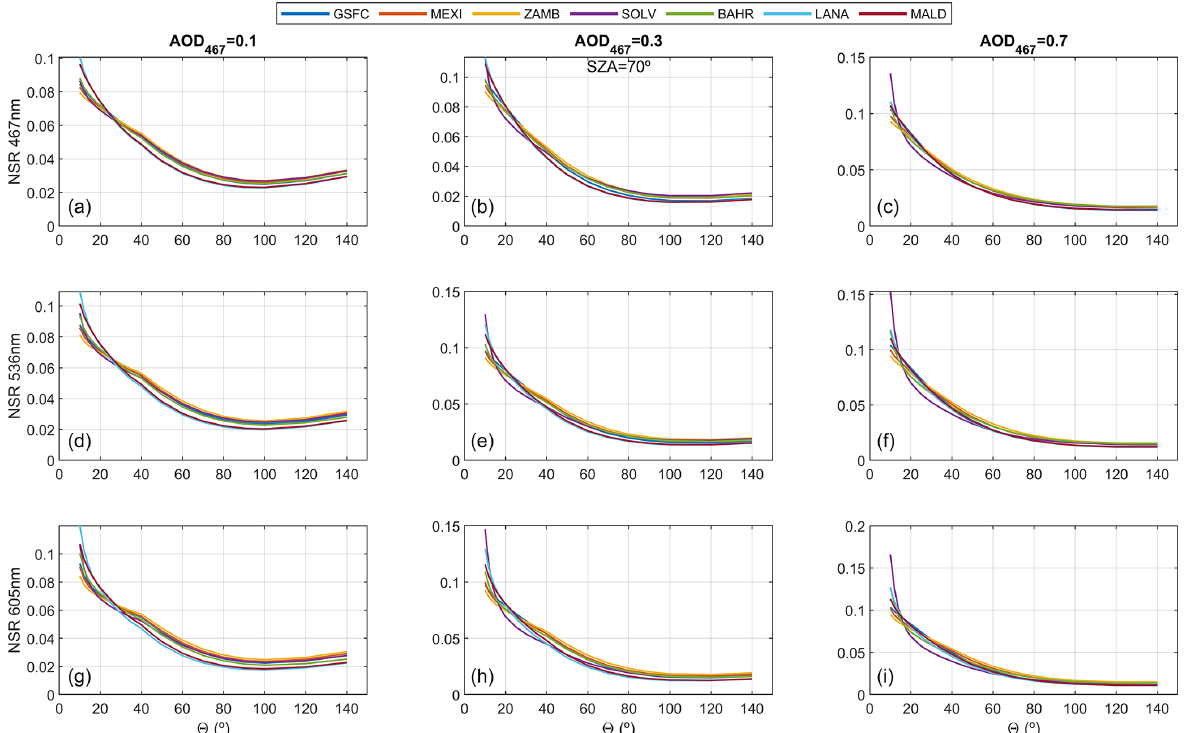
Figure 3. Normalized sky radiance (NSR) with a solar zenith angle (SZA) of 70 ◦ at 467nm (a, b, c) , 536nm (d, e, f) and 605nm (g, h, i) as a function of scattering angle ( (cid:50) ) for different aerosol models. Columns correspond to AOD at 467nm (AOD 467 ) values of (a, d, g) 0.1, (b, e, h) 0.3 and (c, f, i)